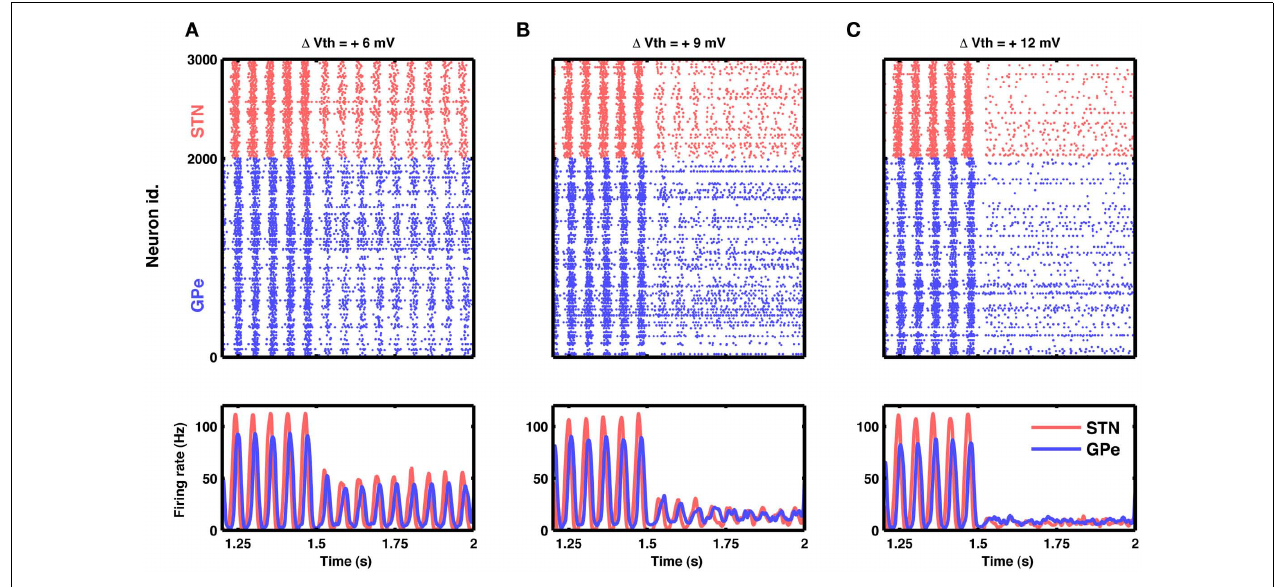
50%. (B) Same as in (A) , but with a spike threshold increase of 9mV. Here the attenuation of oscillations was considerable, down to some 20%. (C) Same as in (A) , but with a spike threshold increase of 12mV. Now the oscillations were nearly abolished, while both STN and GPe remained active at a low firing